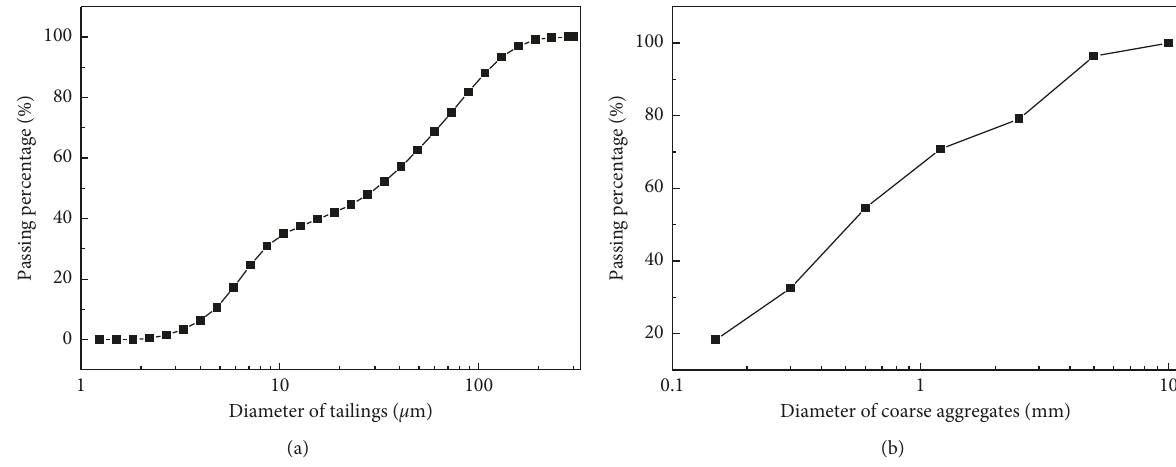
Figure 2: Granular composition curve of the backfill material: (a) granular composition curve of tailings; (b) granular composition curve of coarse aggregates.